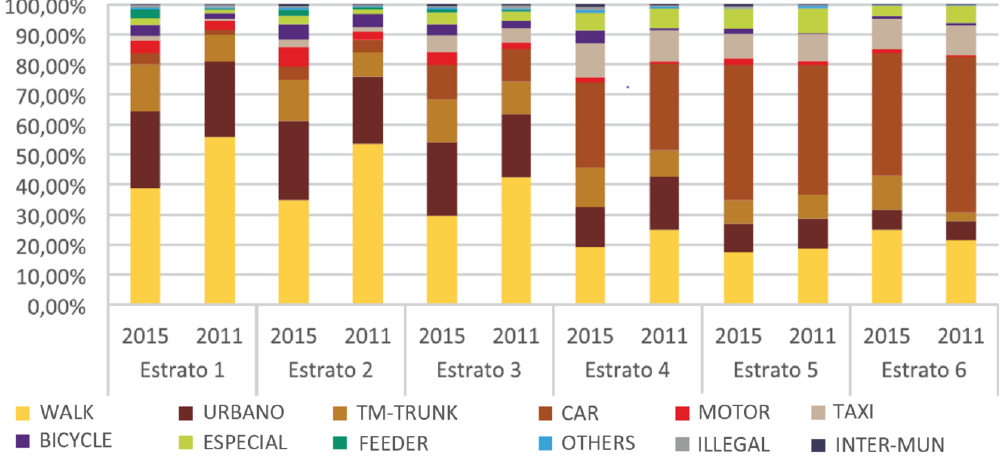
Figure 2. Mode distributions by socio-economic stratum (adapted from [38]). TM-Trunk, Urbano, Especial, and Feeder are all part of the integrated public transport system, Inter-Mun. refers to long distance intercity buses that are not relevant for our study. For further explanation of each system refer to appendix A, section A1.